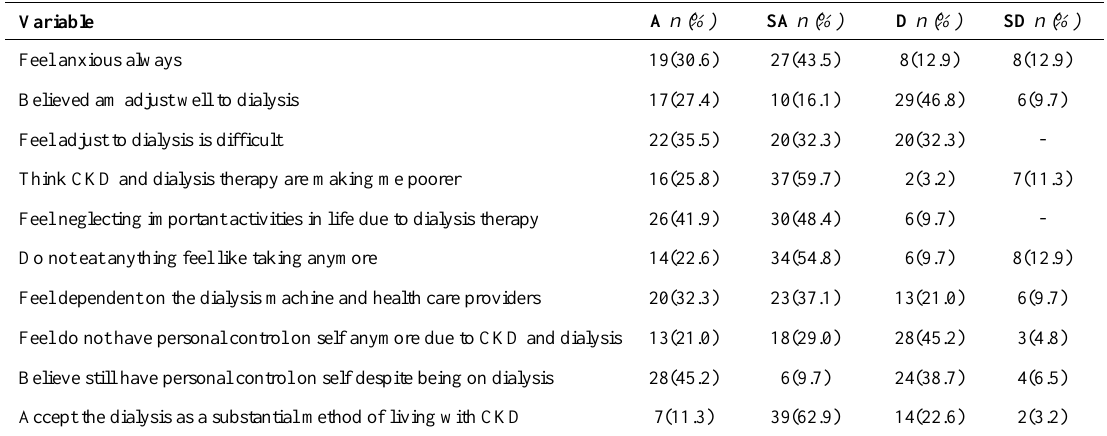
Table 3. Patients perceptions life and social limitations due to CKD and dialysis therapy (n=62)